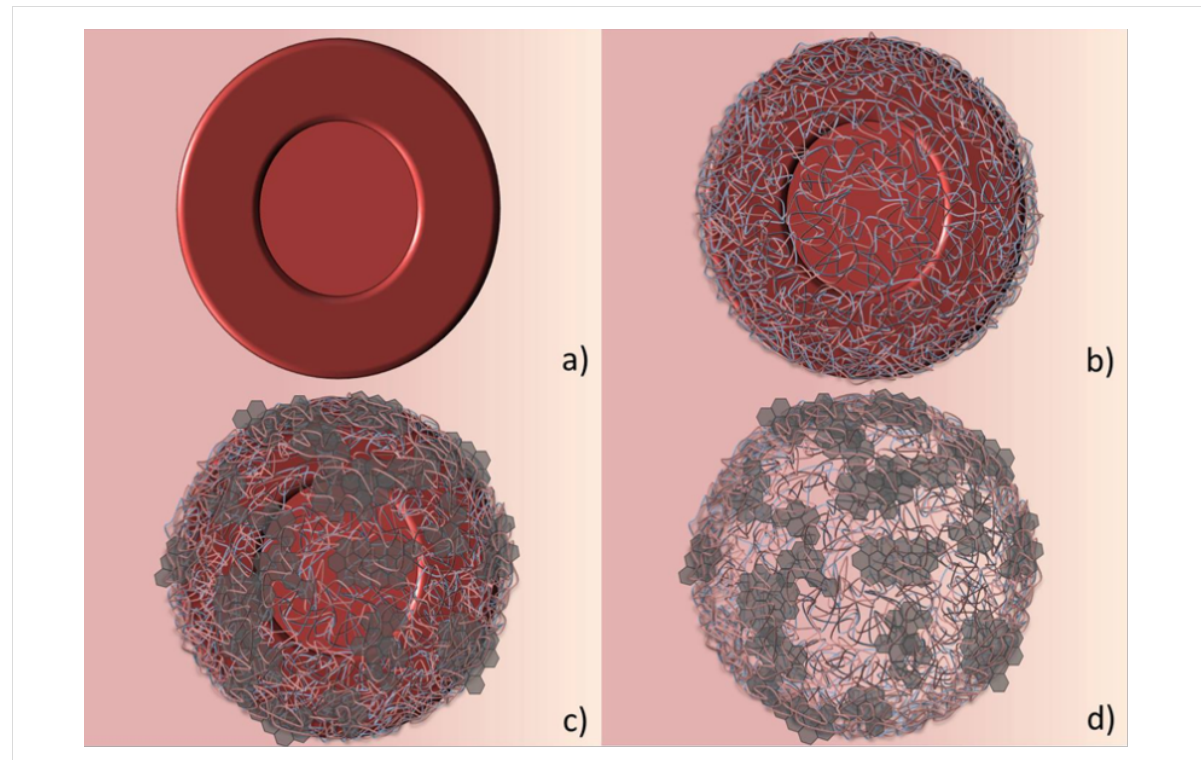
Figure 2: Schematic illustrations of a) the glutaraldehyde fixed red blood cells, b) the fixed erythrocytes coated with four layers of PSS/PAH, c) the fixed cells in (b) coated with additional GO/polyelectrolyte layers and d) the hybrid GO/polyelectrolyte capsule after NaOCl oxidation of the cell.